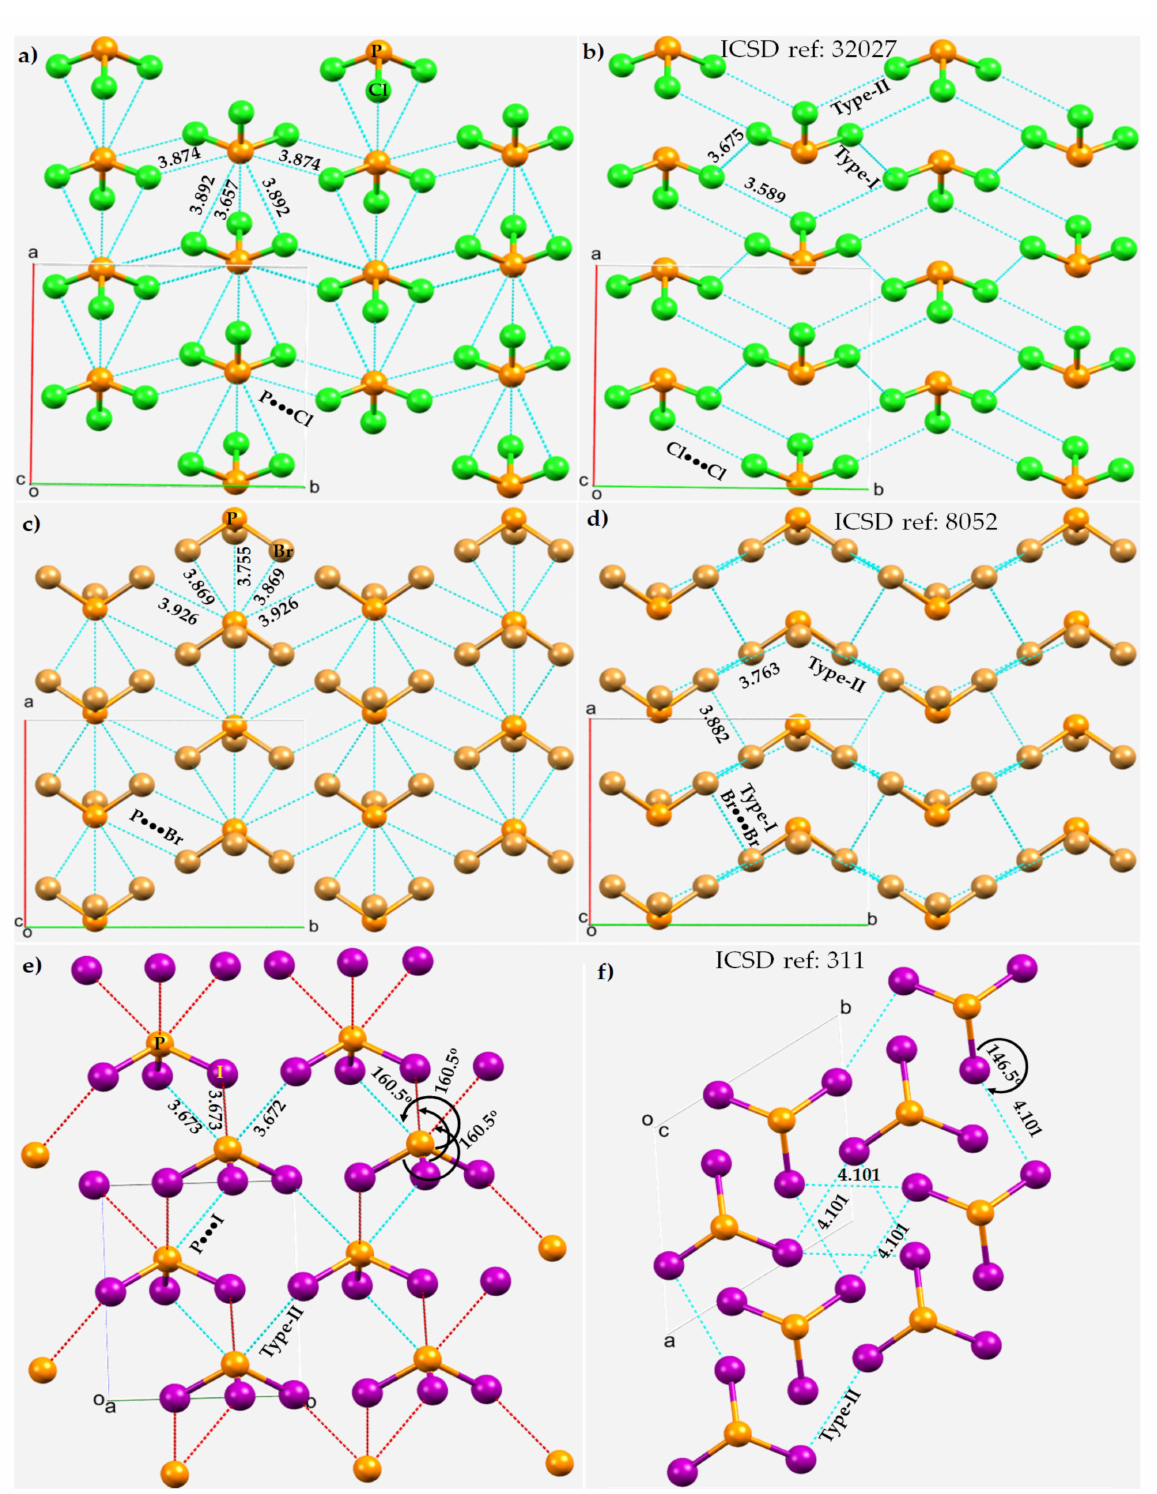
Figure 6. P ··· X and X ··· X bonding modes in the 2 × 2 × 2 supercell crystal structure of PX 3 (X = Cl, Br, I). Selected bond lengths and bond angles are in Å and degrees, respectively. Atom type is shown in each case. ( a ) P ··· Cl and ( b ) Cl ··· Cl in PCl 3 . ( c ) P ··· Br and ( d ) Br ··· Br in in PBr 3 . ( e ) P ··· I and ( f ) I ··· I in PI 3